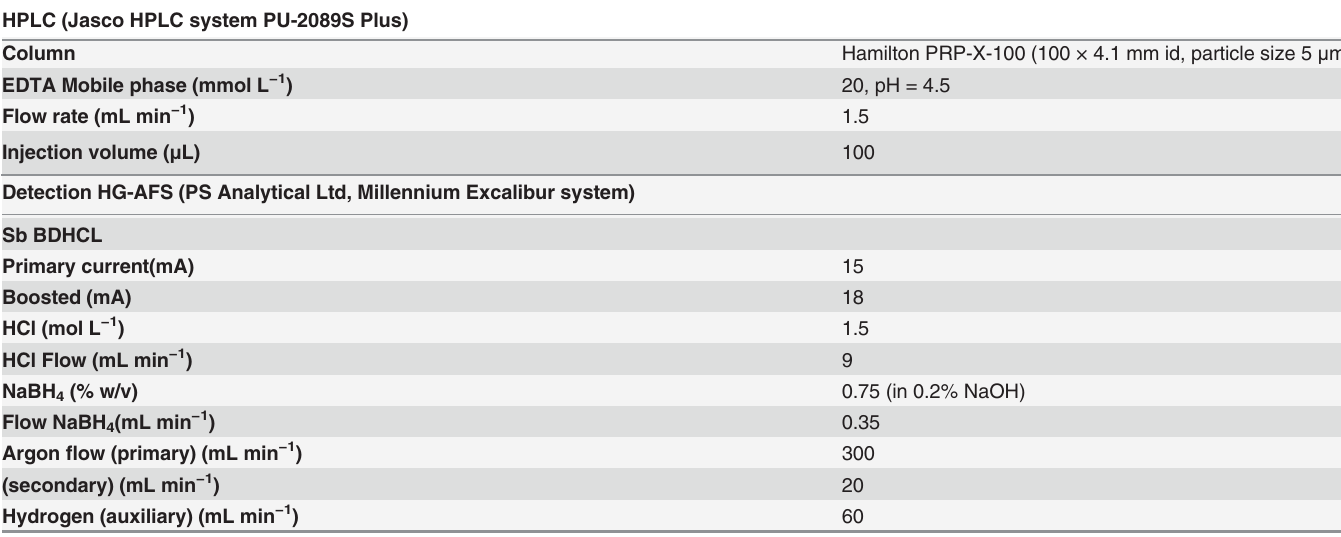
Table 1. Summary of conditions for HPLC coupled to a HG-AFS detection system for the determination of Sb(V) and Sb(III).